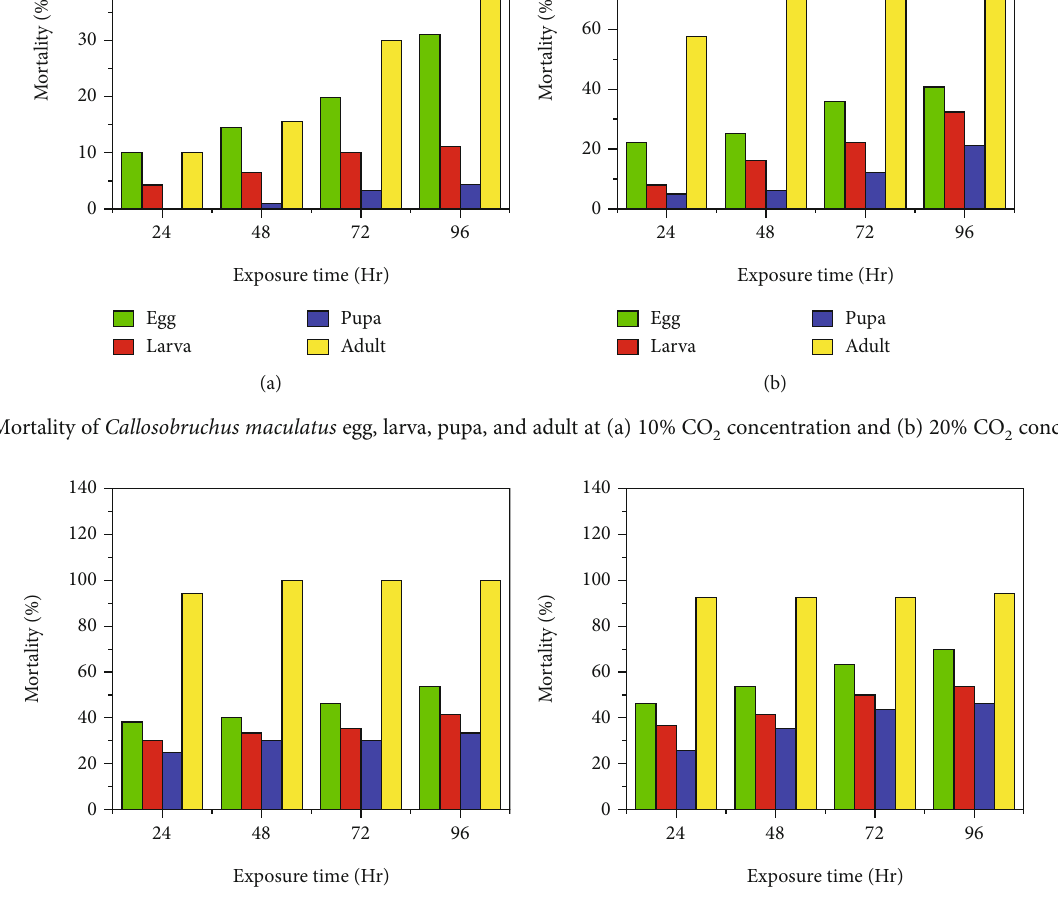
concentration and (b) 40% CO 2 2